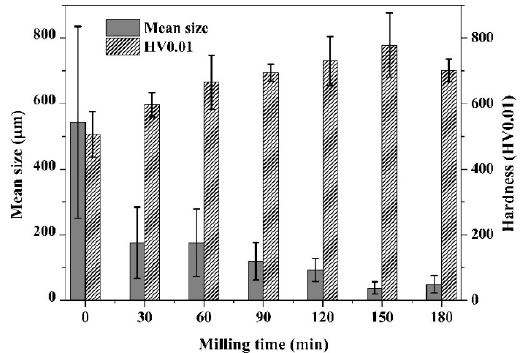
Figure 3. Effect of milling time on the average particle size and hardness.